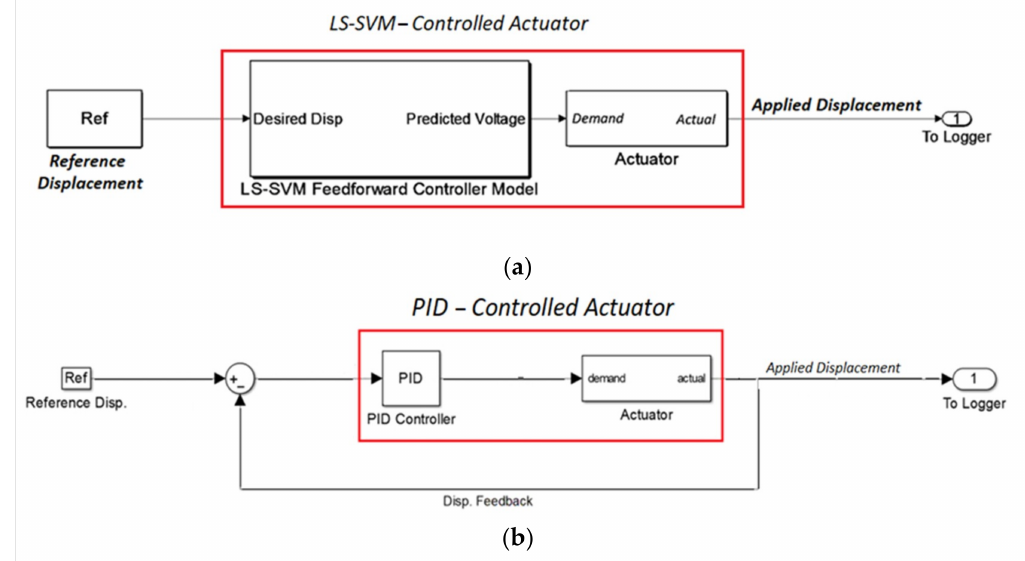
Figure 7. BlockdiagramsofthemodelsusedforStep3; ( a )LS-SVM-controlledplant,( b )PID-controlledplant.